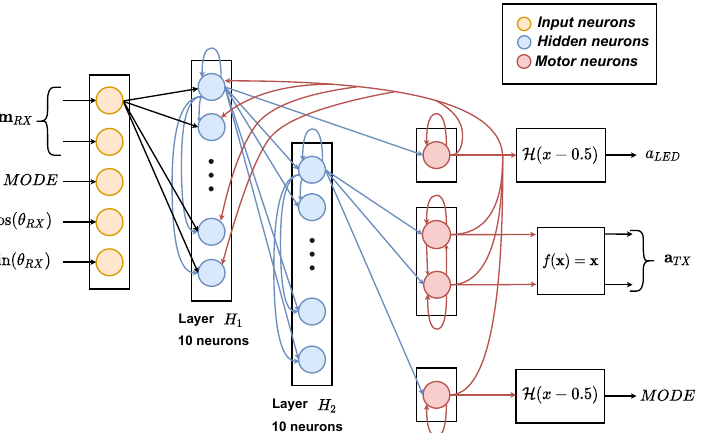
Figure 1. CTRNN architecture of the robot’s controller. In order to simplify the diagram, only the connections of the first neuron of each layer are illustrated. The synapses from the rest of the neurons in the layers have the same post synaptic neurons as the ones depicted for the first unit. The colors of the connection arrows indicate the kind of layer to which the pre synaptic neuron belongs to. Note that input neurons, in yellow, are placeholders of input stimulus and not actual neuron models. The boxes on the right side of the diagram display the firing rate decoding function. H is the Heaviside